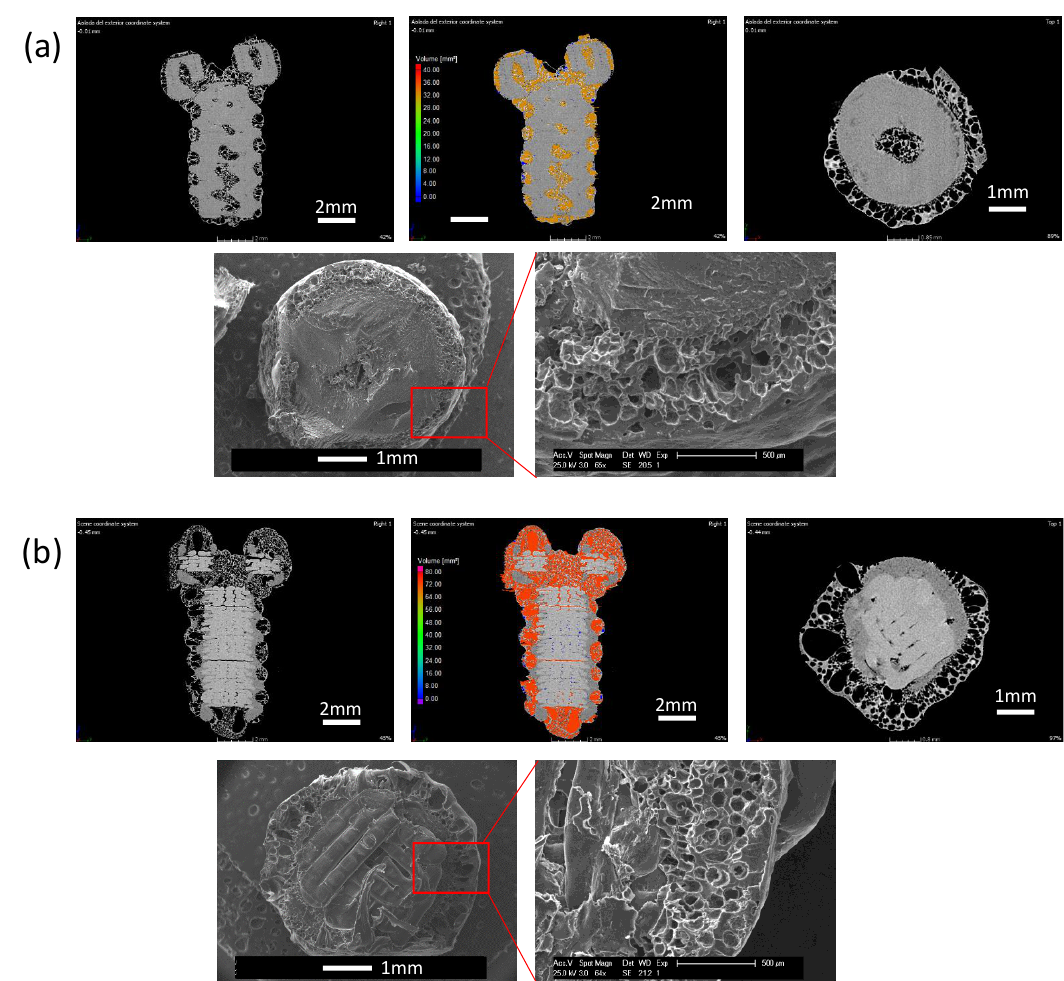
Figure 8. Micro-Computerized Tomography (CT) (above) and SEM (below) cross-sections of illustrative examples in which the samples present a solid internal structure and a porous area limited to the surface layers. ( a ) Screw fabricated in PCL with porous surface. ( b ) Screw with an internal PLA solid structure and a porous PCL external layers.